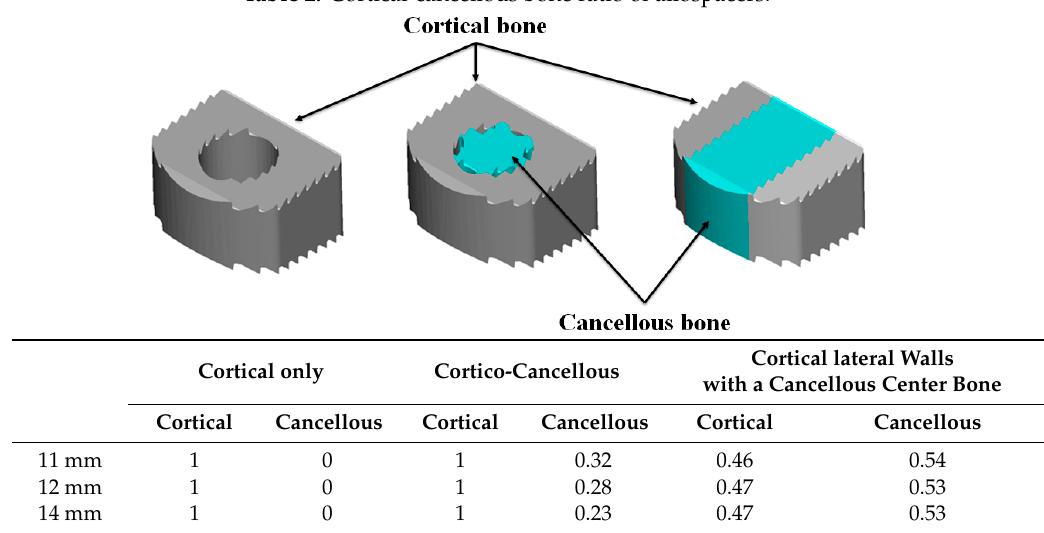
Table 2. Cortical-cancellous bone ratio of allospacers.